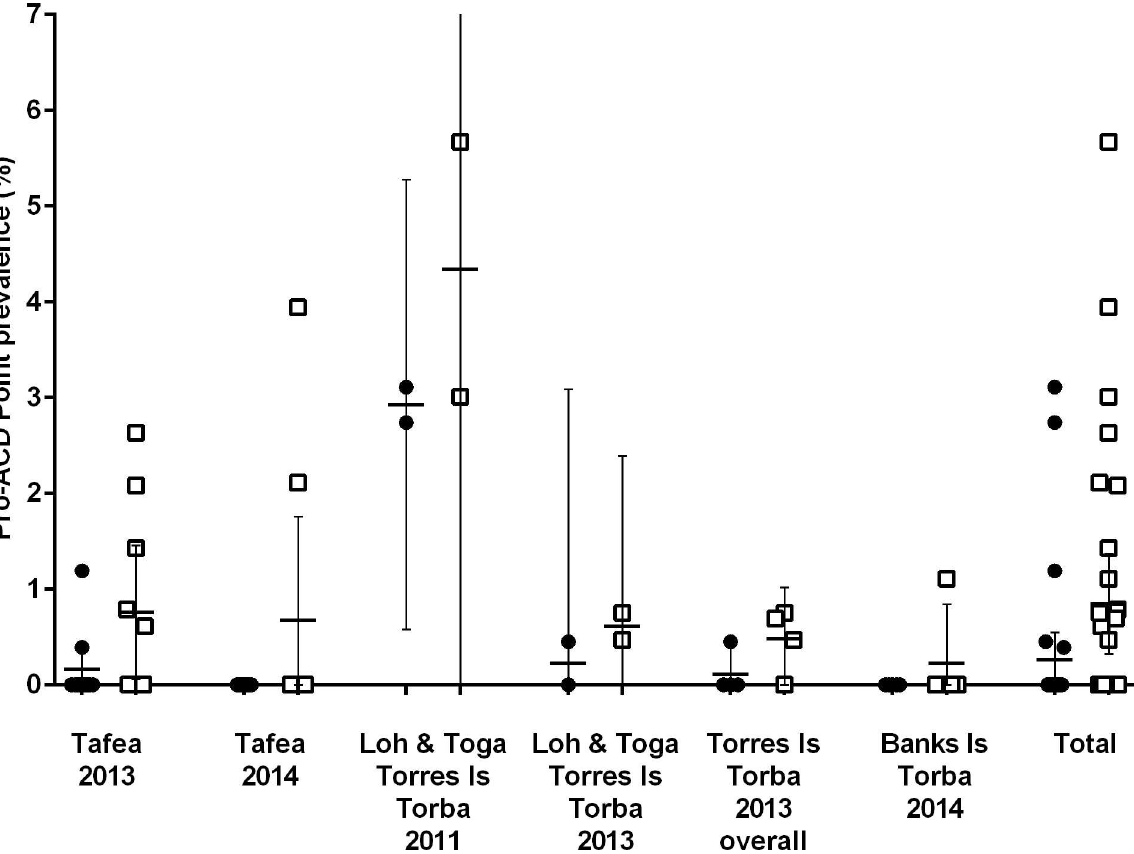
Fig 1. Comparison of RDT and PCR determined point prevalence (mean and 95% CI) of plasmodium infections in Pro-ACD. Filled circles represent RDT results whileopen squaresrepresent PCR results.